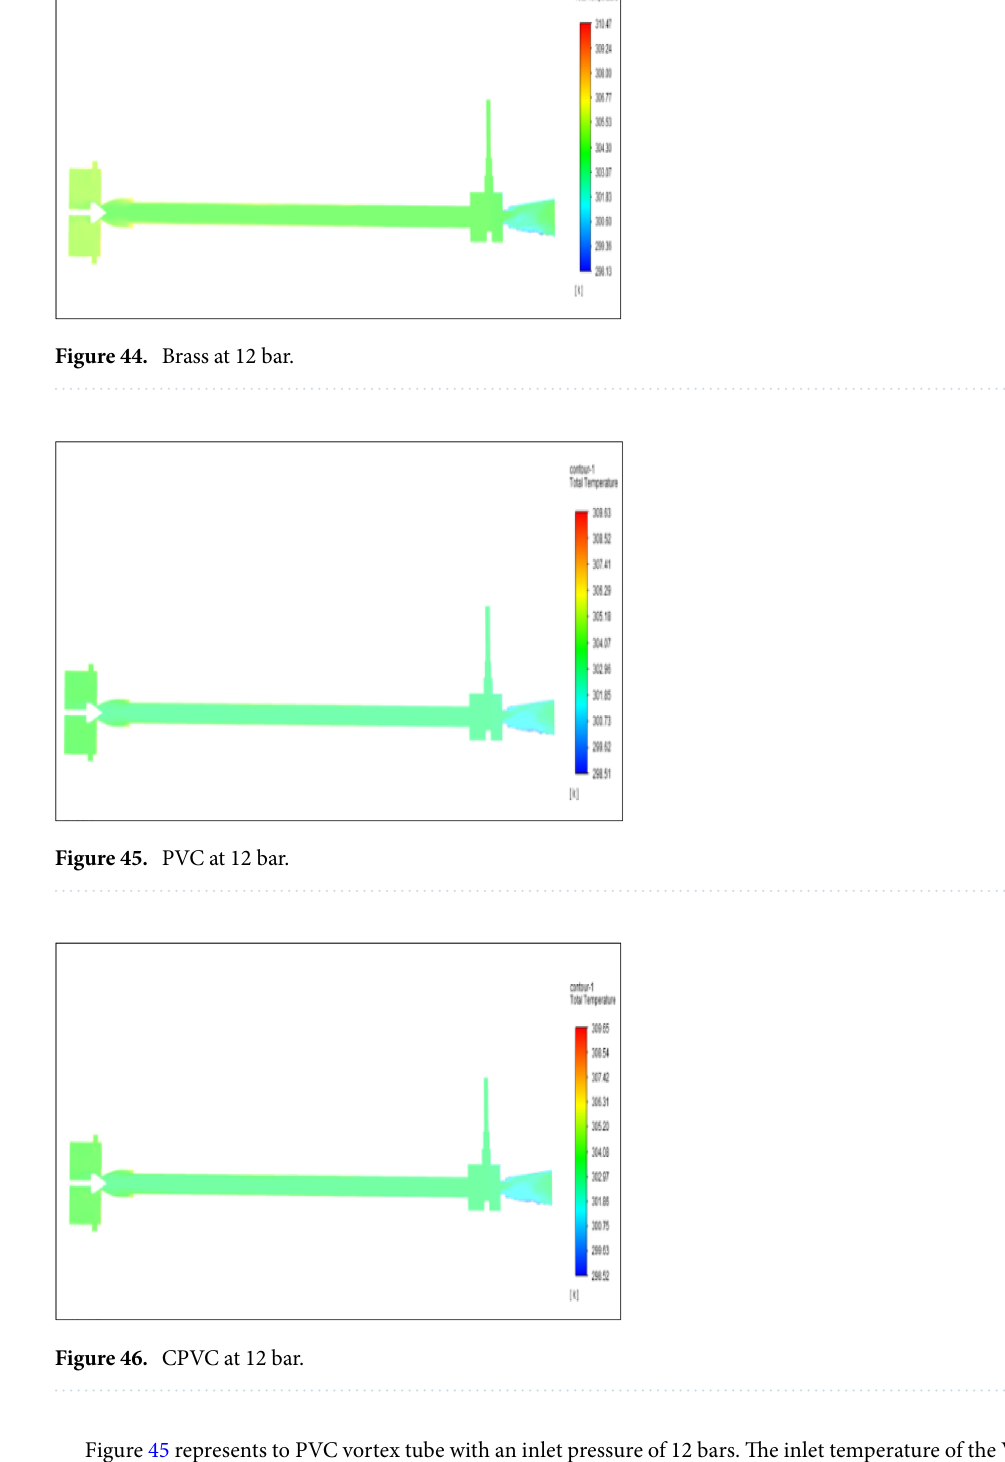
Figure 45 represents to PVC vortex tube with an inlet pressure of 12 bars. The inlet temperature of the VT is 303 K. The hot air temperature was obtained at the hot end as 309.63 K. Similarly at the cold end side obtained a value of temperature as 298.51 K. The maximum temperature difference was noticed as 11.12 K. Figure 46 represents to CPVC vortex tube with an inlet pressure of 12 bars. The inlet temperature of the VT is 303 K. The hot air temperature was obtained at the hot end as 309.64. Similarly at cold end side obtained a value of 298.52 K. The maximum temperature was found to be 11.112 K.